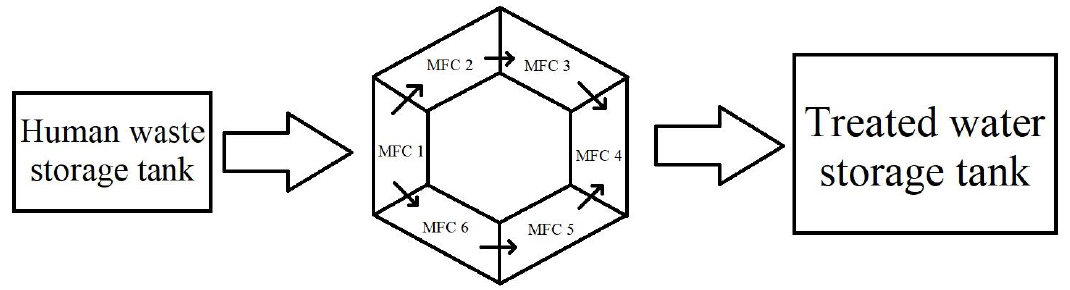
Figure 7. MFC arrangement of Sanitary Wastewater Treatment System. (adapted from Das et al. (2020) [82]).